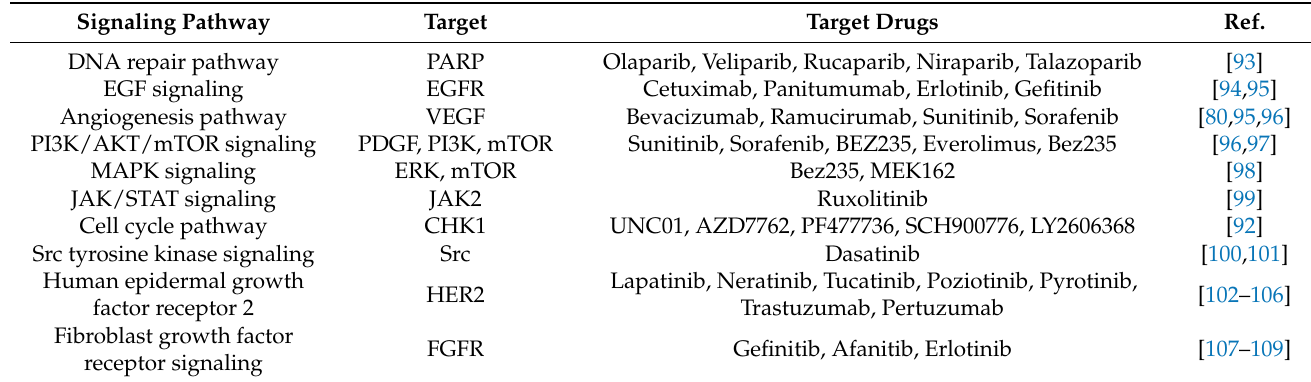
Table 3. Targets and targeted drugs for triple negative breast